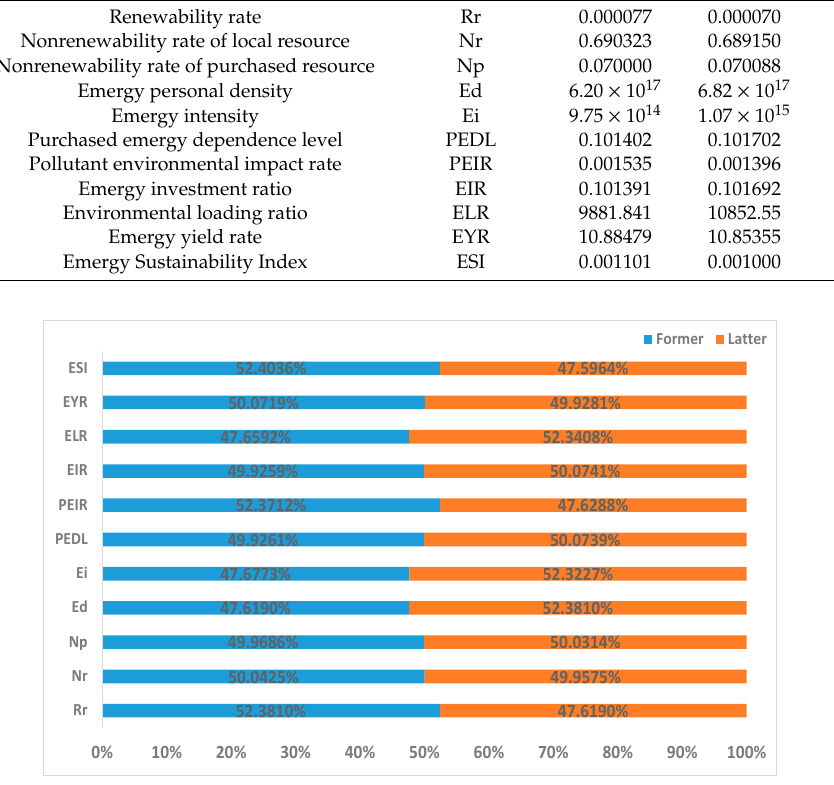
Figure 4. Comparison of all indicators between former and latter.